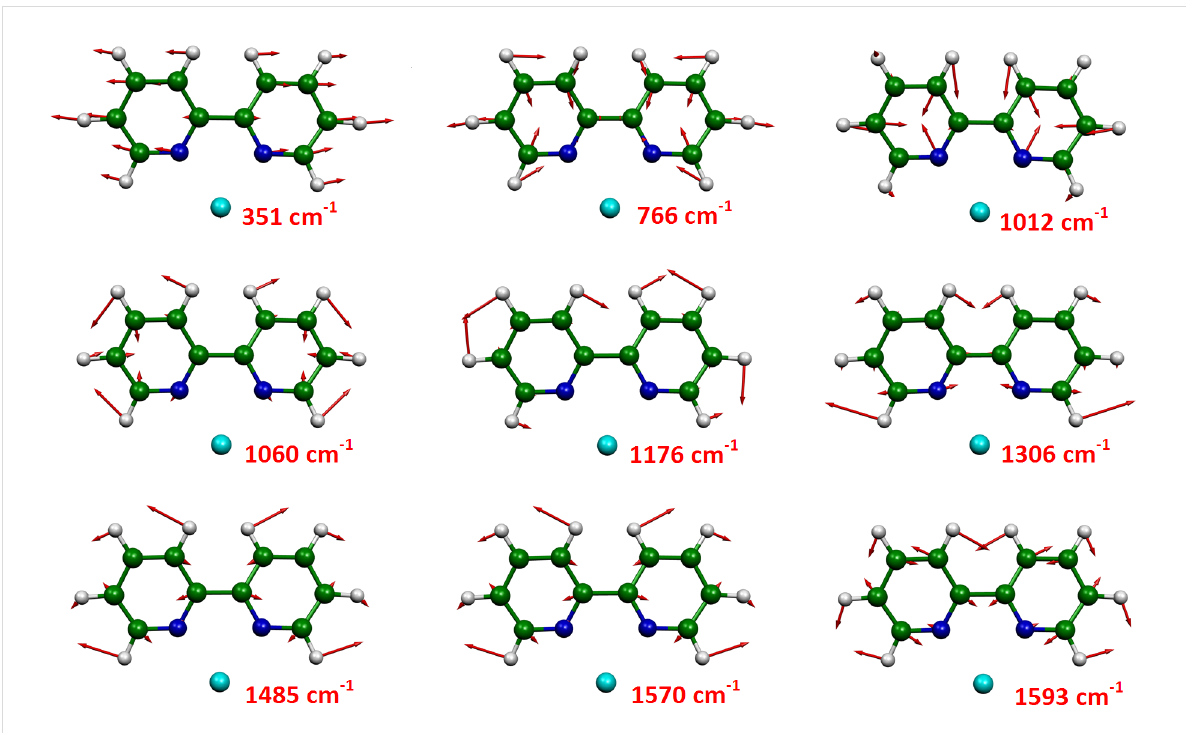
Figure 4: Calculated normal modes in terms of Cartesian displacements, corresponding to the prominent bands observed in the SERS spectra of bpy adsorbed on Ag-doped silica